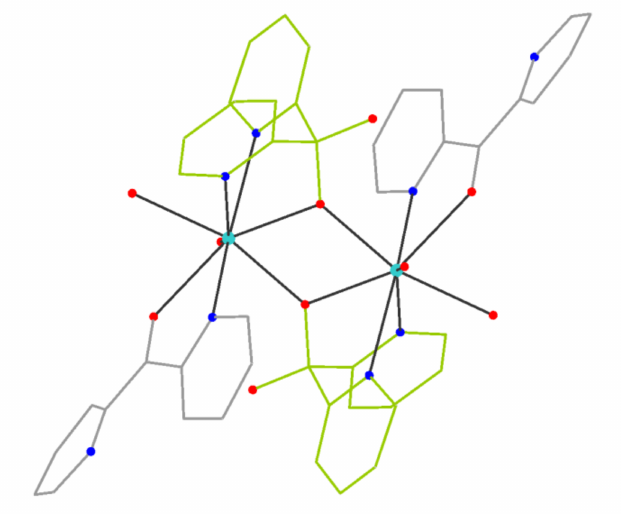
Figure 3. Molecular structure of the complex 3 . Hydroxybis(2-pyridyl)methanolate is shown green. Non-coordinated atoms of the triflates and hydrogens are not shown.